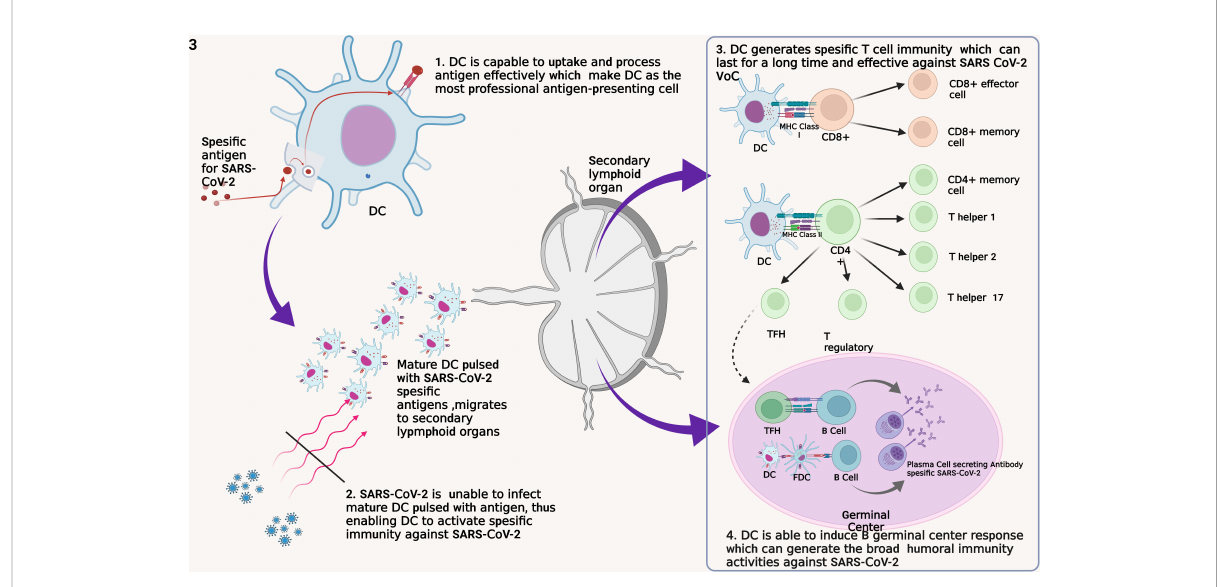
FIGURE 3 Four fundamental reasons for the development of DC as a SARS-CoV-2 vaccine. DC, dendritic cell; FDC, follicular dendritic cell; MHC, major histocompatibility complex; TFH, T follicular